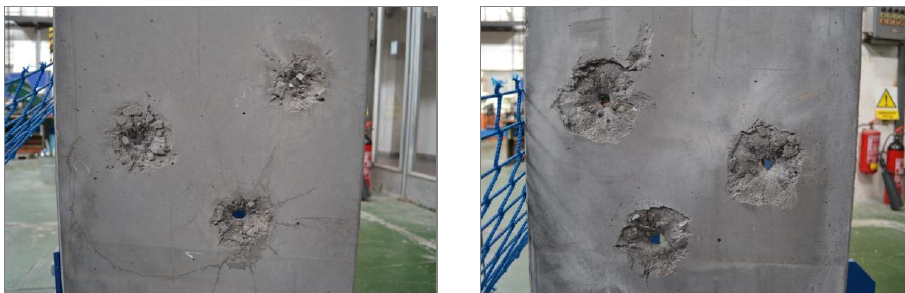
Figure 3. Predamaged slabs: differences between projectiles’ entrance (on the left) and exit (on the right) side.